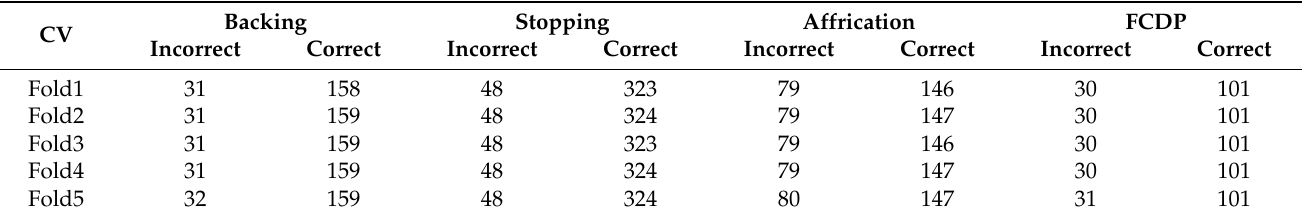
Table 5. The amount of data on the single-Chinese-character dataset for validation.